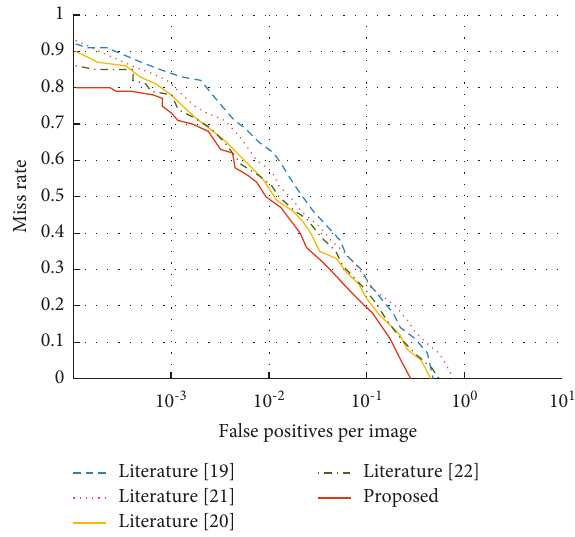
Figure 6: The MR-FPPI result of the PASCAL VOC